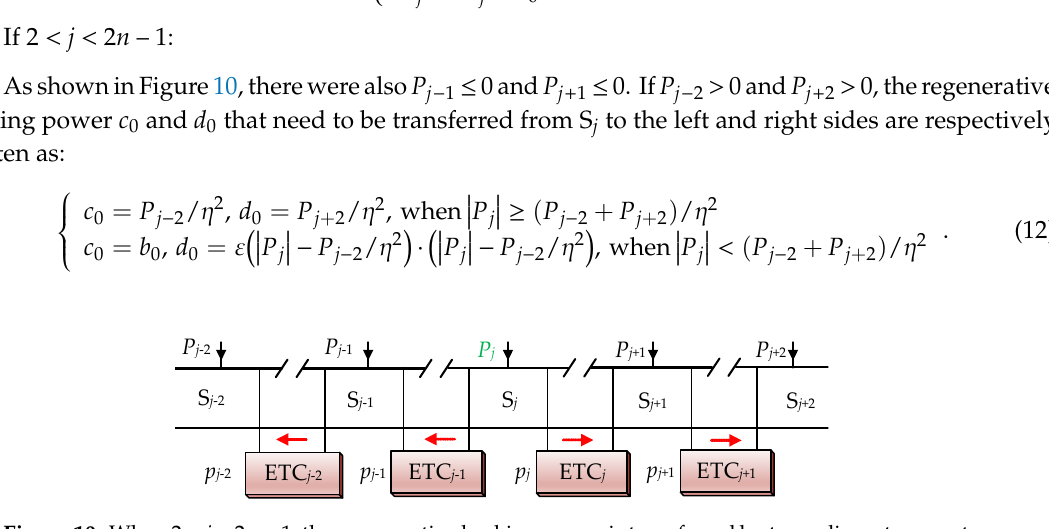
Figure 10. When 2 < j < 2 n − 1, the regenerative braking power is transferred by two adjacent